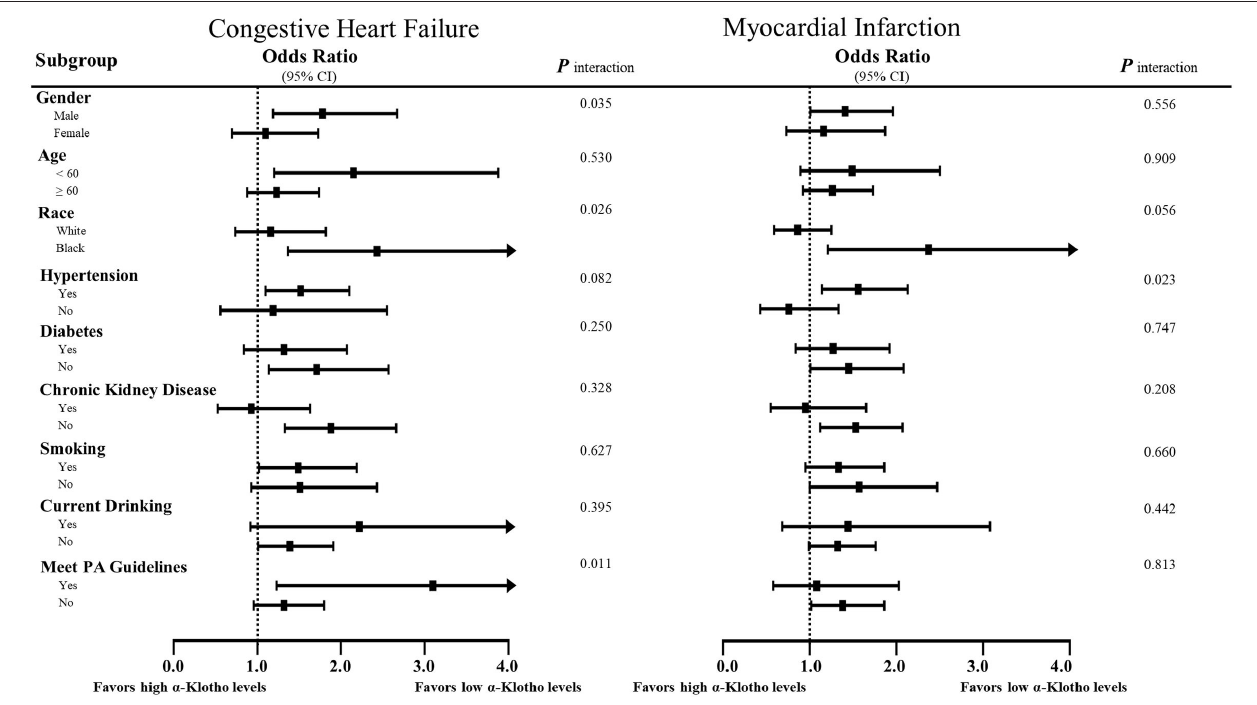
FIGURE 5 | Subgroup analyses of the associations of serum soluble α -Klotho with CHF and MI. Risks of heart failure and MI of the lowest quartile of α -Klotho, as defined by equal to or < 646.4 pg/ml, compared to the highest quartile of α -Klotho. The results are expressed as fully adjusted ORs after controlling for covariates, such as age, sex, body mass index, race, education, smoking, drinking, diabetes, hypertension, physical activity, white blood cell counts, neutrophil-to-lymphocyte ratio, platelet counts, total cholesterol, triglycerides, low-density lipoprotein cholesterol, high-density lipoprotein cholesterol, serum calcium, serum phosphorus, urine albumin, estimated glomerular filtration rate, HbA1c, energy intake, total fat intake, and medications. In addition, possible interactions between the above factors were also adjusted if